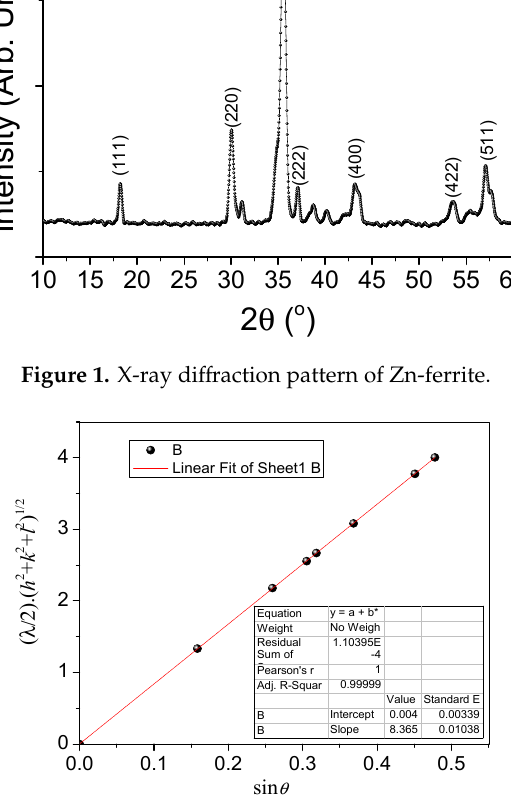
= − 0.37631 ± 2.24235, 0